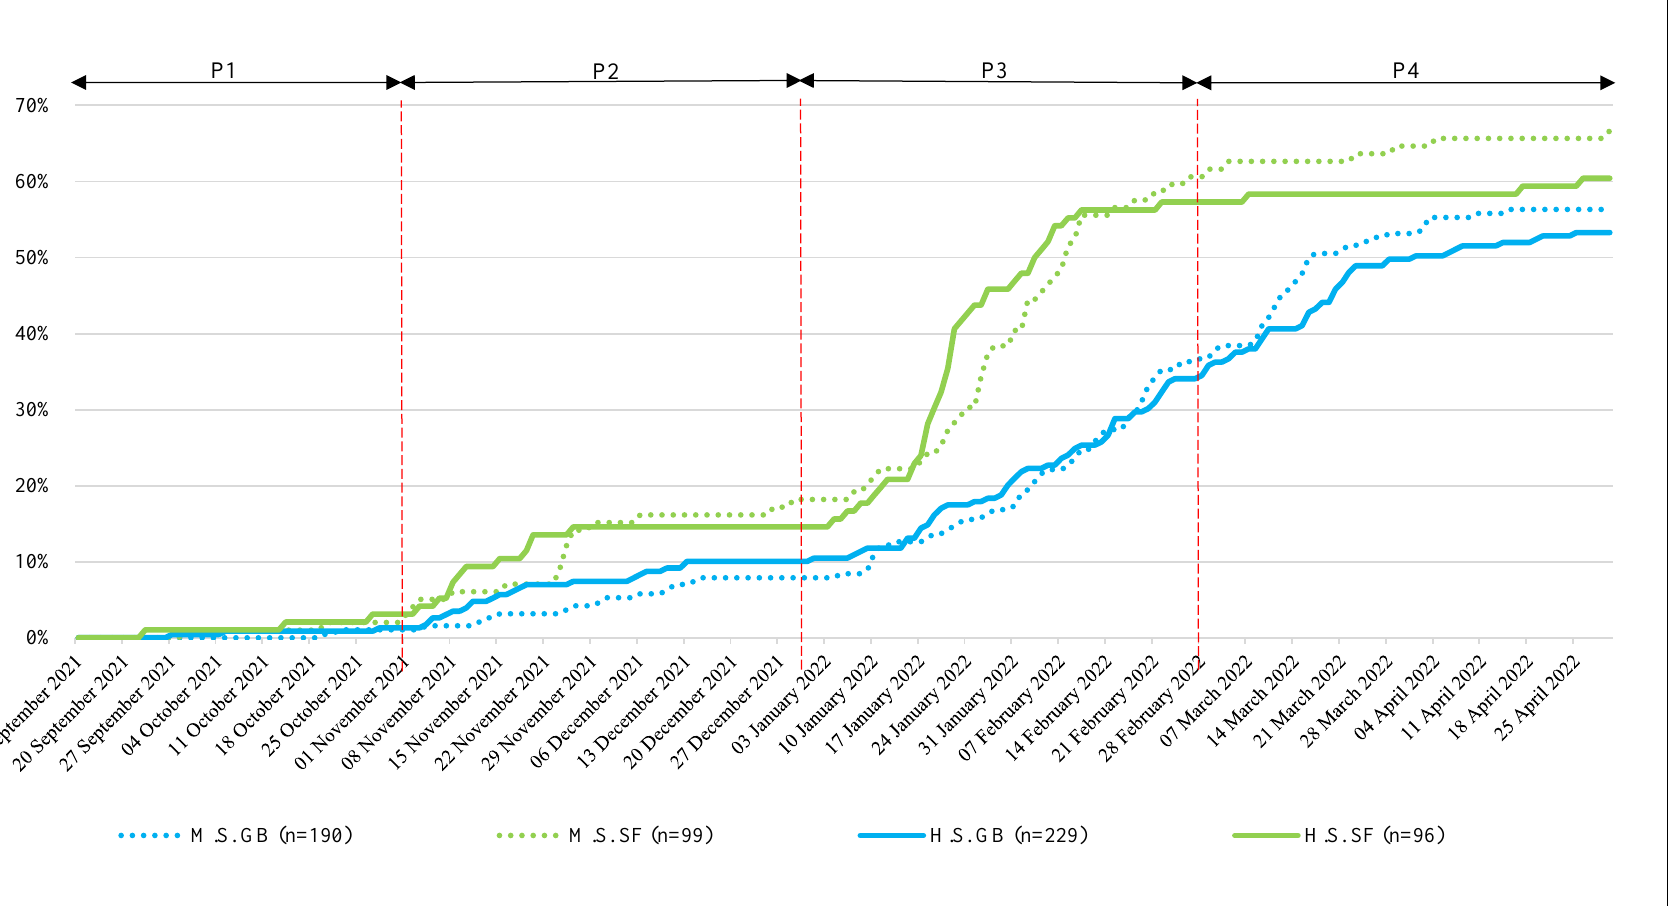
Figure 1. Cumulative percentage of students with SARS-CoV-2 infections. SARS-CoV-2 = severe acute respiratory syndrome coronavirus 2, P1 = period 1 (13